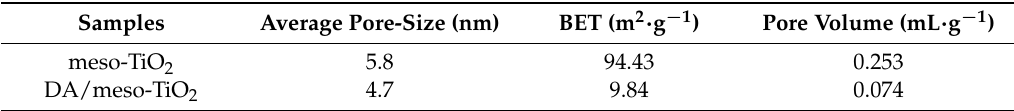
2 and ( b ) DA/meso-TiO 2